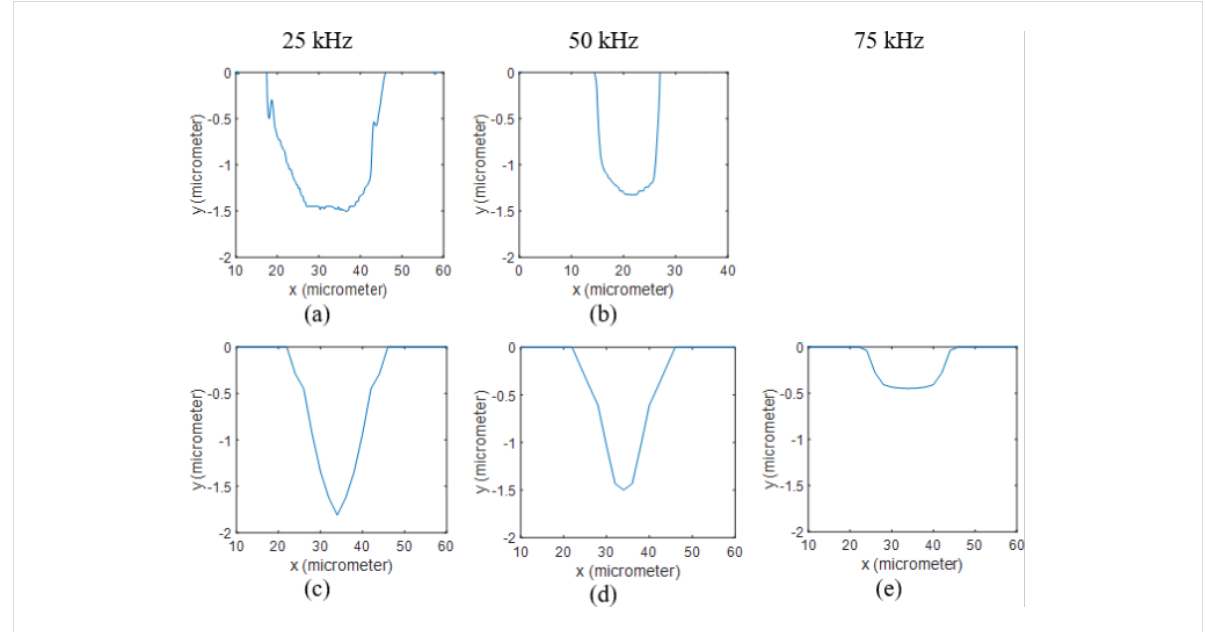
Figure 1: 2D profiles of uncoated Si samples processed at 5 W. Results obtained from measurements when using (a) 25 kHz and (b) 50 kHz are compared to the ones calculated through the numerical model at (c) 25 kHz, (d) 50 kHz and (e) 75 kHz.